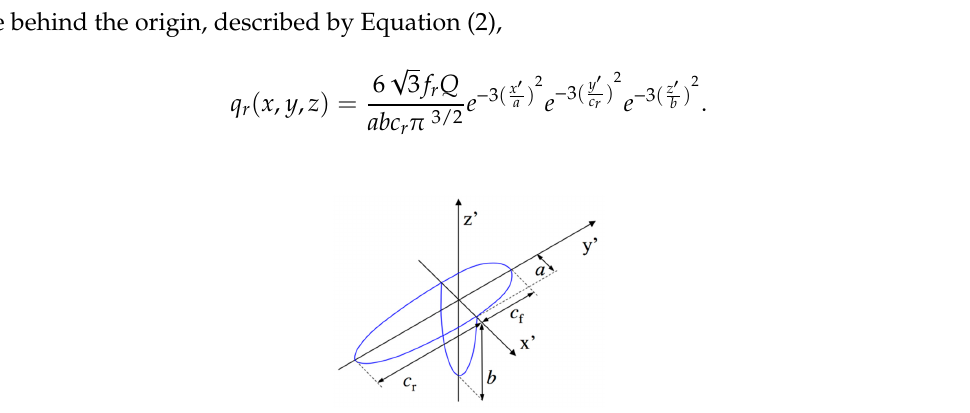
Figure 3. Double ellipsoidal heat source [45].